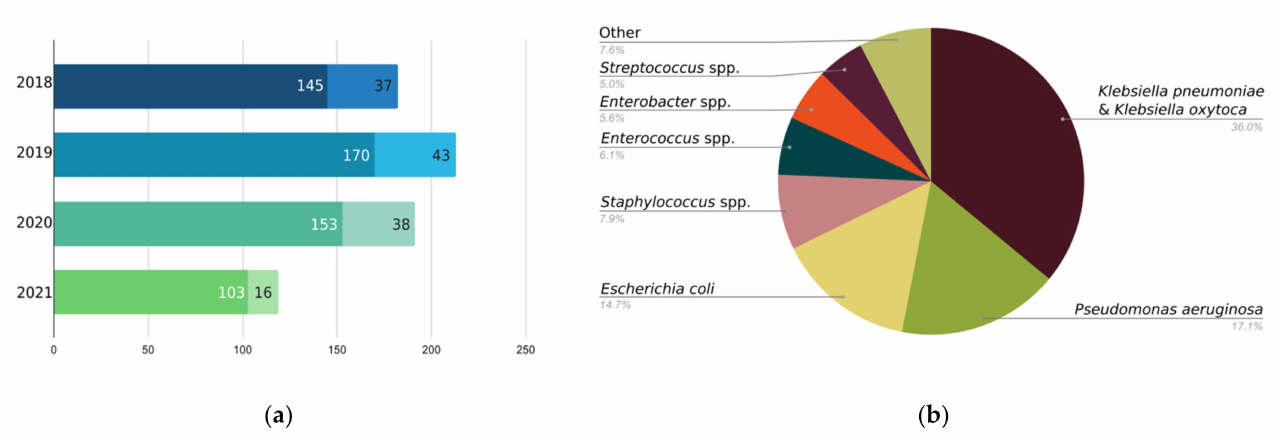
Figure 1. EPTC custom phage orders according to years ( a ) and bacterial species targeted by requested custom phages ( b ). Three full years and 6 months of the year 2021 are shown. Values in white (left part of the bar—darker shade of bar color) indicate numbers of primary custom phage orders, while values in black (right part of the bar—lighter shade of bar color) indicate numbers of custom phage re-orders from the same patients ( a ). Bacterial species distribution is shown cumulatively for 705 custom phage orders received since 2018 ( b